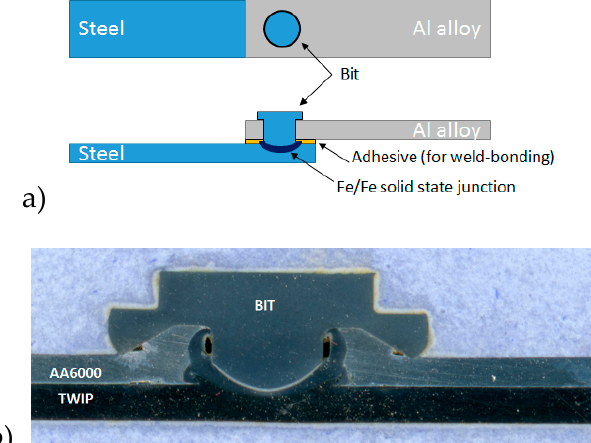
Figure 14. Friction bit joint configuration ( a ) and metallographic section of and FBJ spot ( b